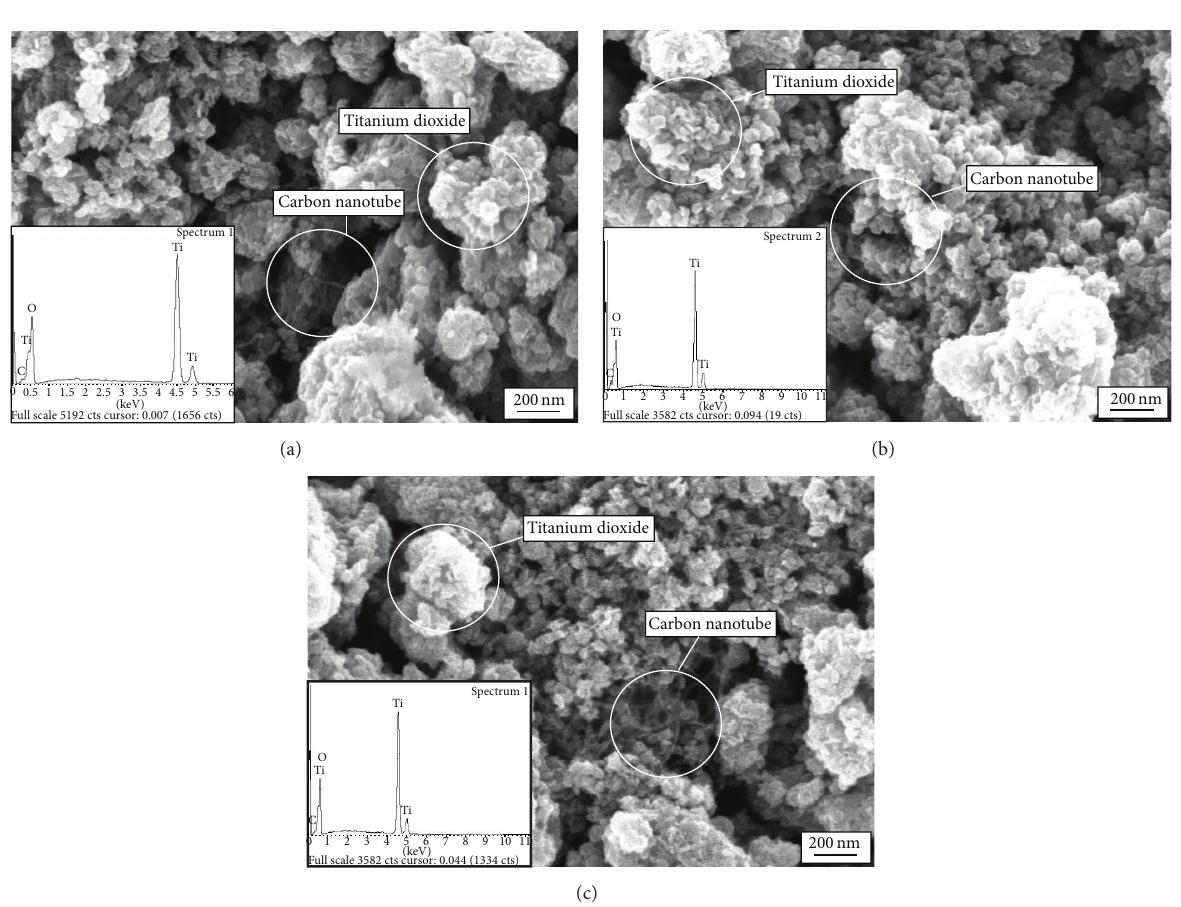
patterns were (101), (004), (200), and (211) at 25.2 ∘ , 37.96 ∘ , ∘ ∘ , and 55.40 , respectively, for the anatase phase, and the 47.84 peak was (211) at 54.04 ∘ for the rutile phase. The major peaks corresponded to the anatase phase with a crystallographic plane of (101) at 25.2 ∘ for all the films. The rutile phase was hardly observed and only occurred in the thin film annealed at 750 ∘ C. Brookite phase was not observed in these